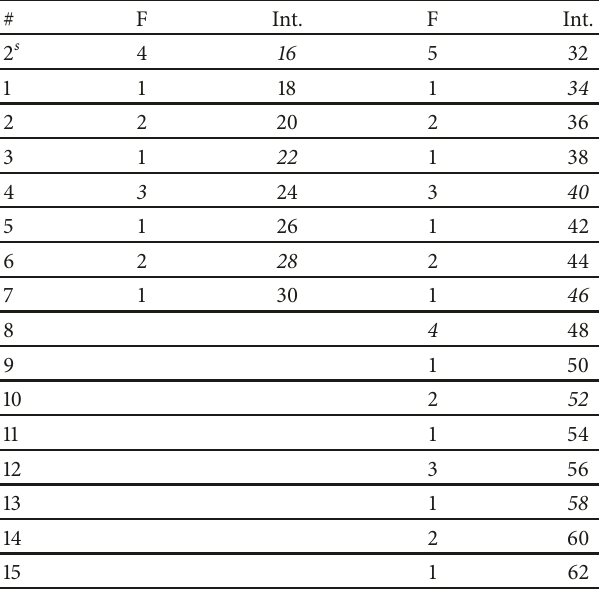
Table 3 represents 50:50 probability of the Collatz